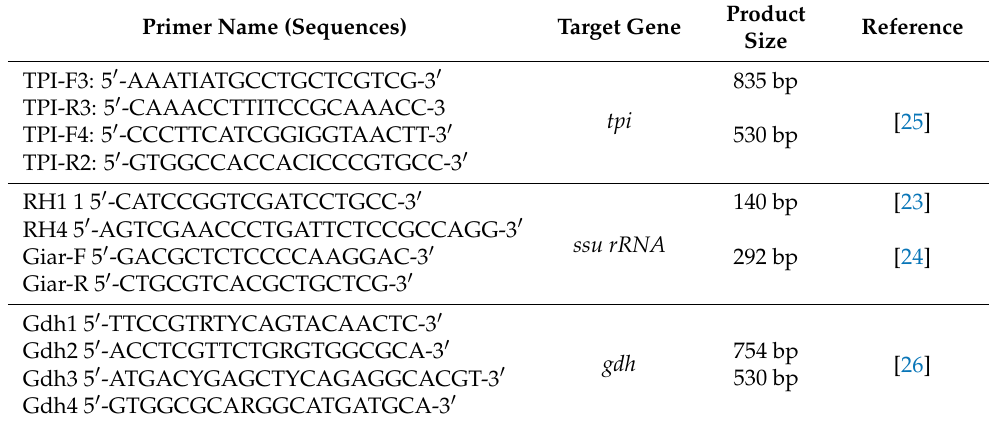
Table 1. List of primers used for genetic characterization of Giardia in prairie dog fecal